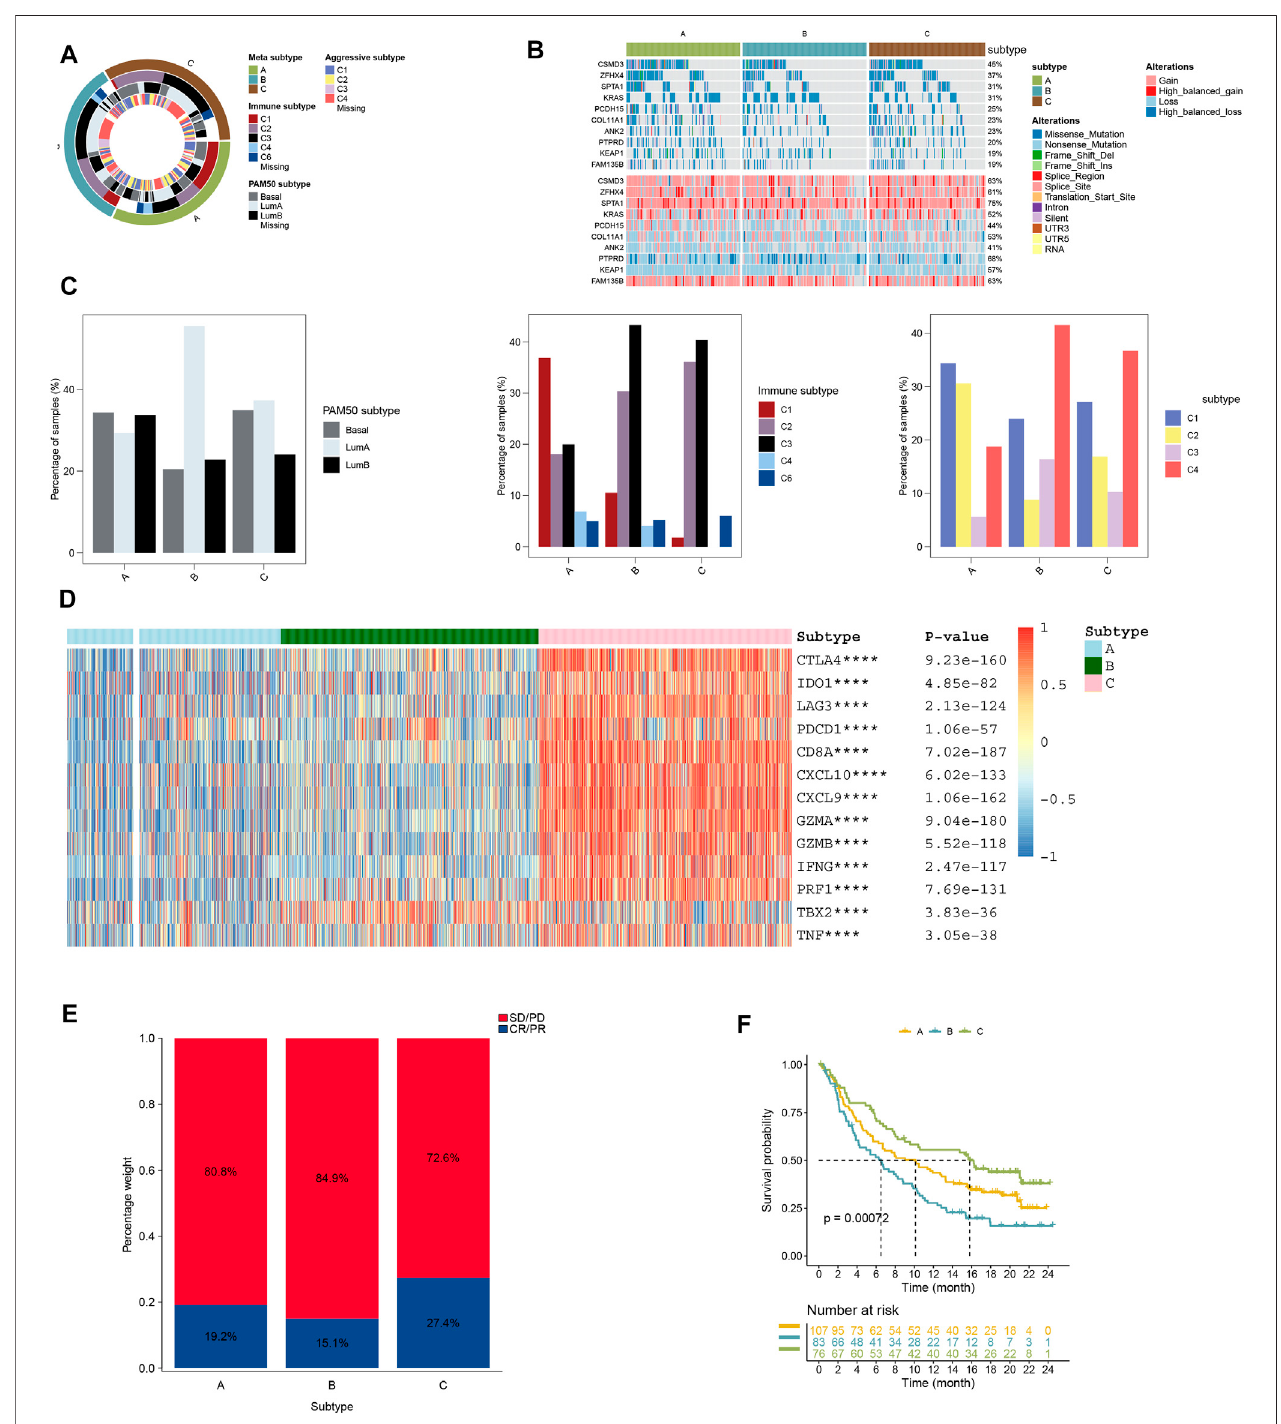
FIGURE3|(A) Overlayofdifferentclusters(innerring)withLUADexpression subtypes (outerring). (B) Oncoprint distributionsofsomatic mutation(SNV/indel)and copy number variation (CNV) events in different clusters. (C) Distribution of immune, aggressive luminal, and basal subtypes in different clusters. (D) Distribution of immune-related gene expression in different clusters. (E) Rate of clinical response to anti-PD-L1 immunotherapy in different clusters, and (F) Kaplan – Meier curves for samples with different clusters in the IMvigor210 cohort.